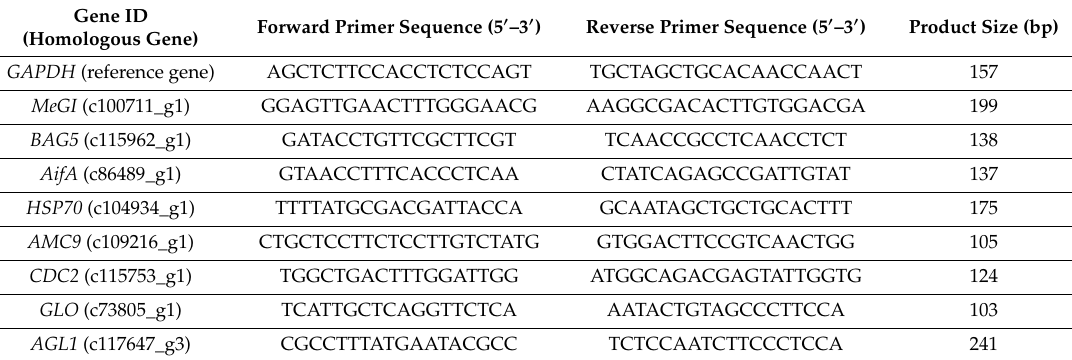
Table 3. Sequences of primers used to study programmed cell death (PCD)-related genes. Gene ID Forward Primer Sequence (5 (cid:48) –3 (cid:48) (Homologous Gene)